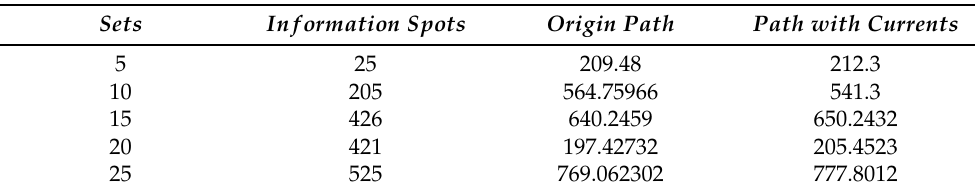
Table 5. The weighted distance costs of planned paths with and without current fields. There are small differences between the outputs of these two scenarios. A possible reason is the positive and negative influences of current fields offsetting each other.